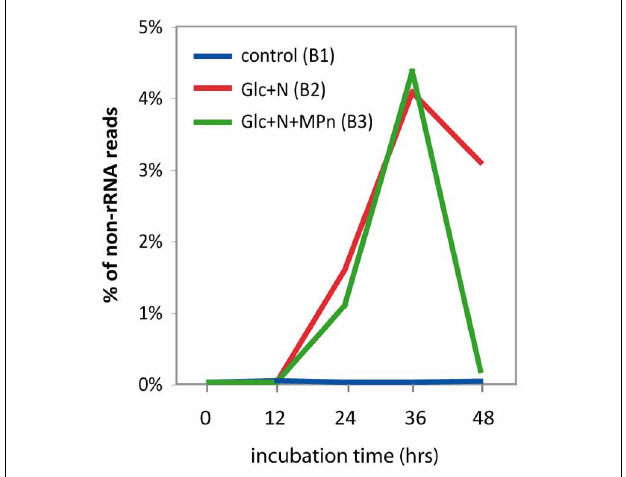
FIGURE 7 | Relative abundance of CsrB/RsmB sRNA in metatranscriptomic datasets. Abundance is expressed as the percentage of non-rRNA sequences matching CsrB with a significance cut off of b >